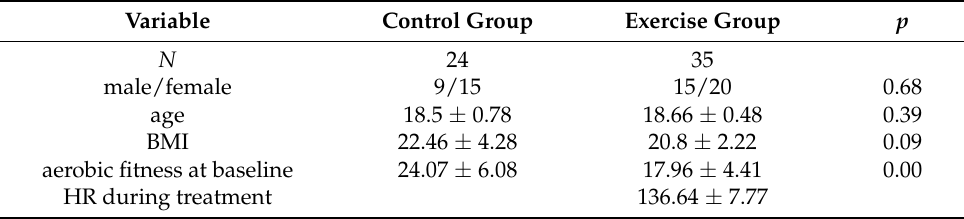
Table 1. Participant demographics (M ± SD).